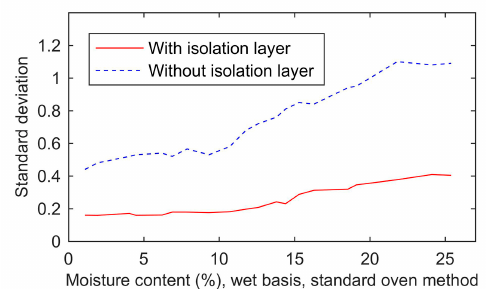
Figure 18. The influence of the isolation layer on the standard deviation.